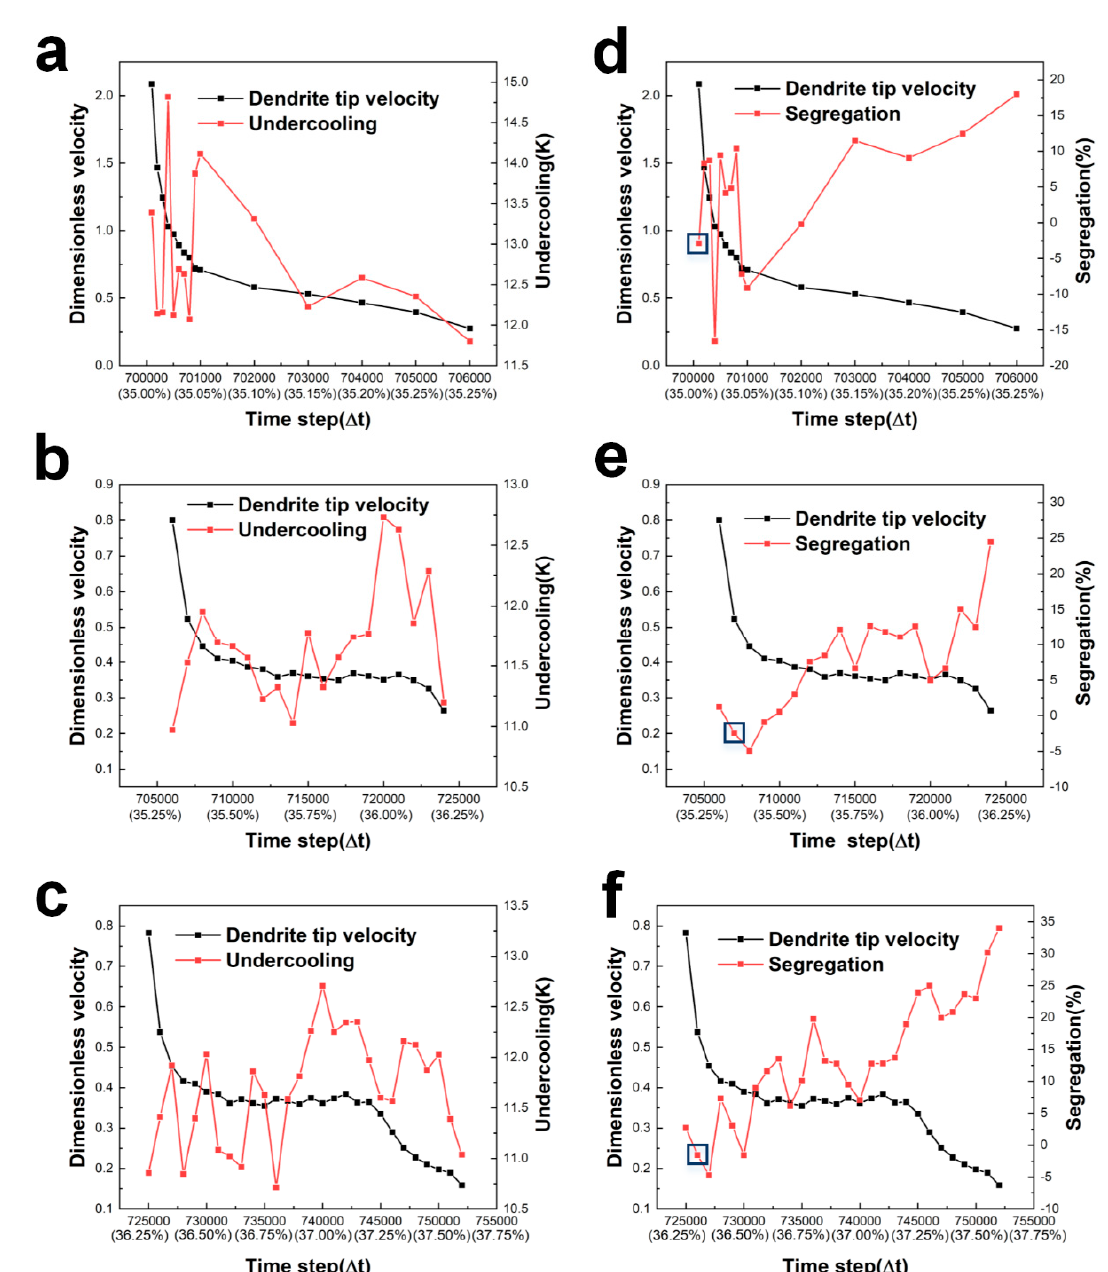
Figure 15. The dimensionless velocity and undercooling variations of equiaxed dendrite tip with time for U n = 11 K and X f = 200 ∆ x : ( a ) D n = 200 ∆ x ; ( b ) D n = 400 ∆ x ; ( c ) D n = 500 ∆ x . The velocity and solute segregation variations of columnar dendrite tip with time for U n = 11 K and X f = 200 ∆ x : ( d ) D n = 200 ∆ x ; ( e ) D n = 400 ∆ x ; ( f ) D n = 500 ∆ x .